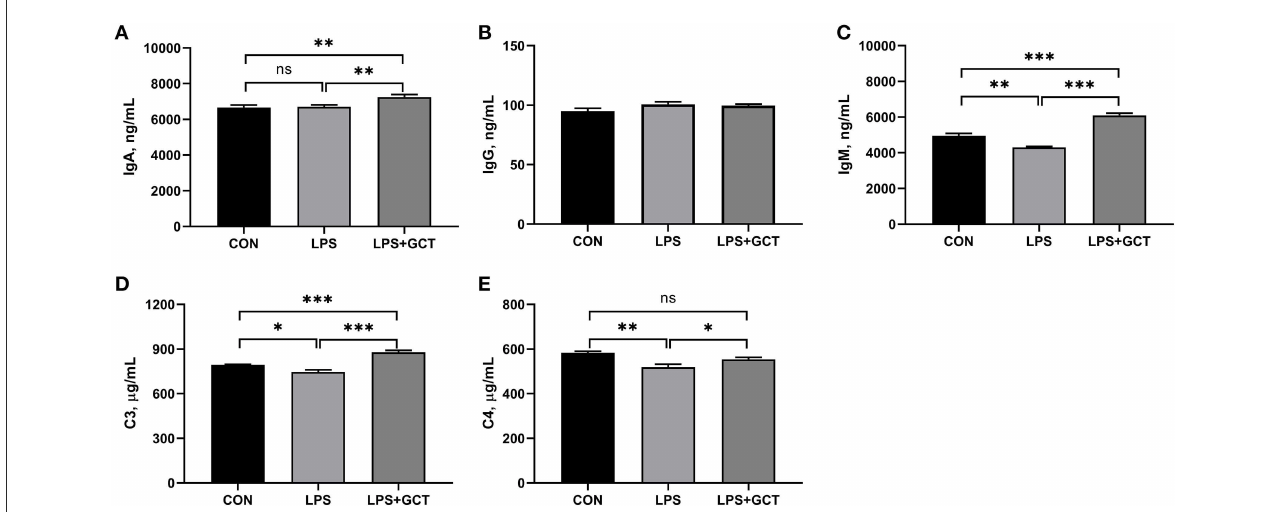
FIGURE3 Effects of dietary Galla Chinensis tannin (GCT) supplementation on serum immunoglobulins and complements of broiler chickens under lipopolysaccharide (LPS)- challenge. (A) Immunoglobulin A (IgA); (B) Immunoglobulin G (IgG); (C) Immunoglobulin M (IgM); (D) Complement C3; (E) Complement C4. CON, fed on a basal diet and intraperitoneally injected with saline solution; LPS, fed on a basal diet and intraperitoneally injected with LPS; LPS + GCT, fed on a basal diet supplemented with 300 mg/kg GCT and intraperitoneally injected with LPS. Values are presented as mean ± standard